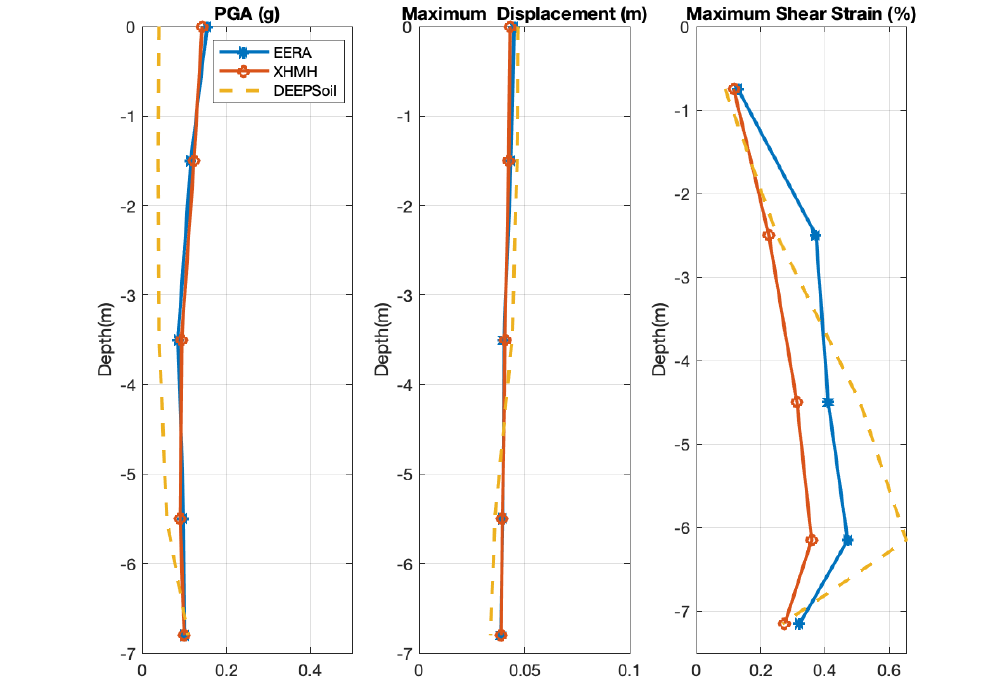
Figure 6. PGA, Maximum Displacement, and Maximum Shear Strain for each